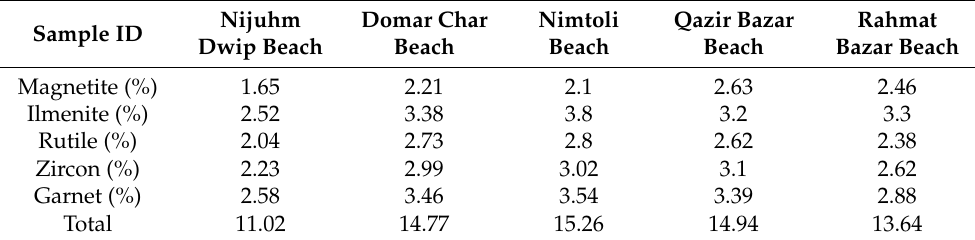
Table 3. The concentration of the valuable heavy mineral (VHM) percentage was determined using the XRD technique.